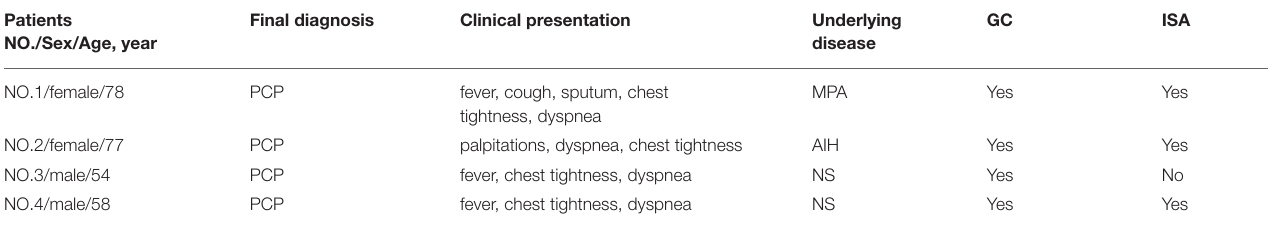
TABLE 1 | Clinical characteristics of patients. Patients NO./Sex/Age, year